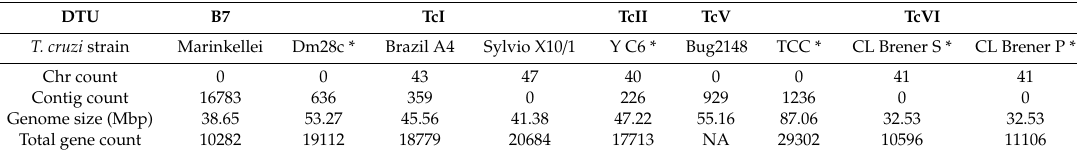
Table 1. T. cruzi genomes available in TritrypDB. With the exception of T. cruzi marinkellei (sequenced by Illumina technology-Illumina Inc., San Diego, CA, USA) and the CL Brener strain (reference genome sequenced by whole genome shotgun assembly), the strains were sequenced by PacBio technology. NA: Not Annotated / * chosen strains for formal